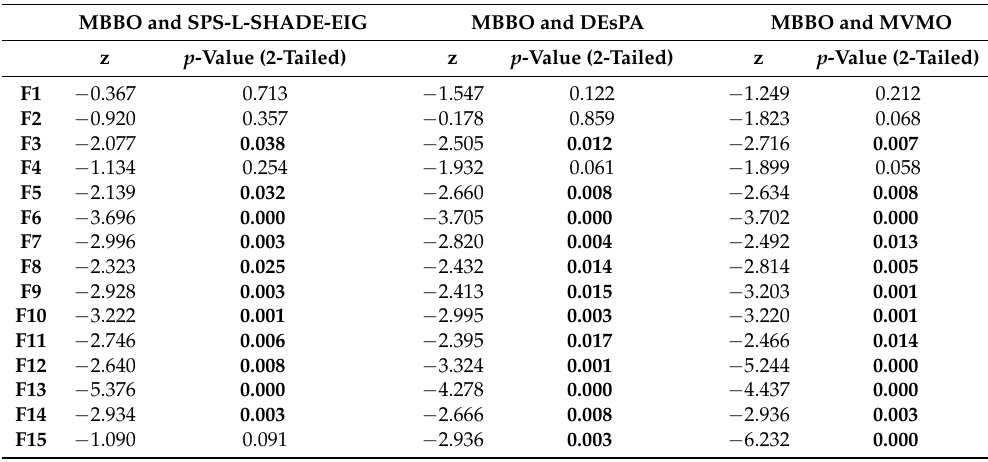
Table 3. The statistical comparison of the MBBO algorithm with the other three algorithms, using the Wilcoxon signed-rank test with freedom at a 0.05 level of significance and 95 % confidence level. MBBO and SPS-L-SHADE-EIG MBBO and DEsPA MBBO and